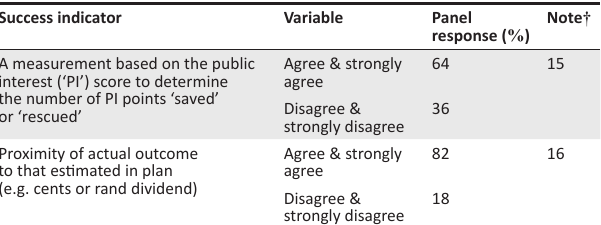
TABLE 7: Additional business rescue success criteria. Success indicator Variable Panel